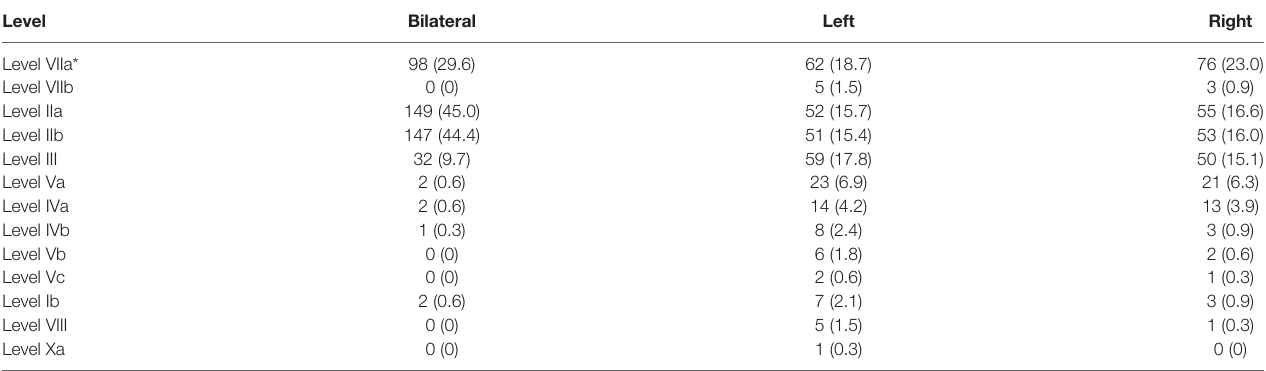
*Medial group of retropharyngeal lymph node metastasis in 1